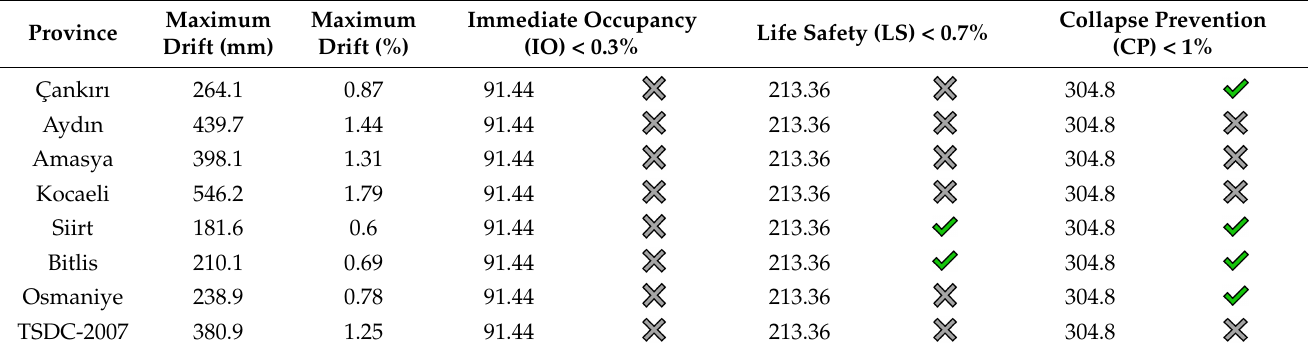
Table 14. Design earthquake drift controls.